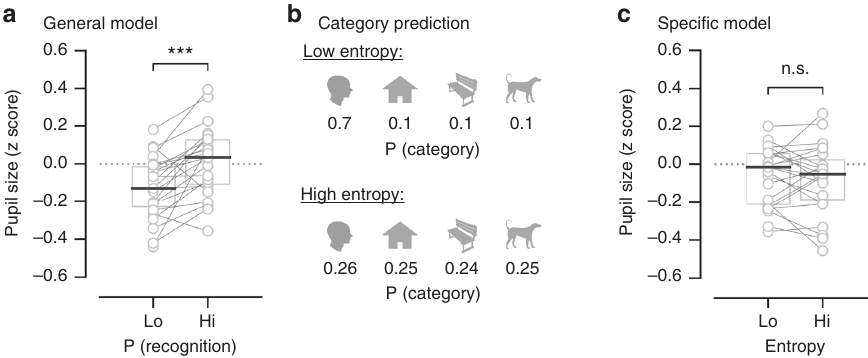
Fig. 5 General, but not speci fi c, spontaneous neural process is related to pupil-linked arousal. a Pre-stimulus pupil size as a function of recognition probability predicted by the General neural process. b Illustration of stimulus category prediction with low and high entropy (top and bottom panels, respectively), re fl ecting certainty of prediction on two different trials. c Pre-stimulus pupil size as a function of the uncertainty (quanti fi ed by entropy) in stimulus category prediction made by the Speci fi c neural process. Wilcoxon signed-rank test was used to assess the difference between the groups ( N = 23, one subject excluded due to eye-tracking failure). Source data are provided as a Source Data fi